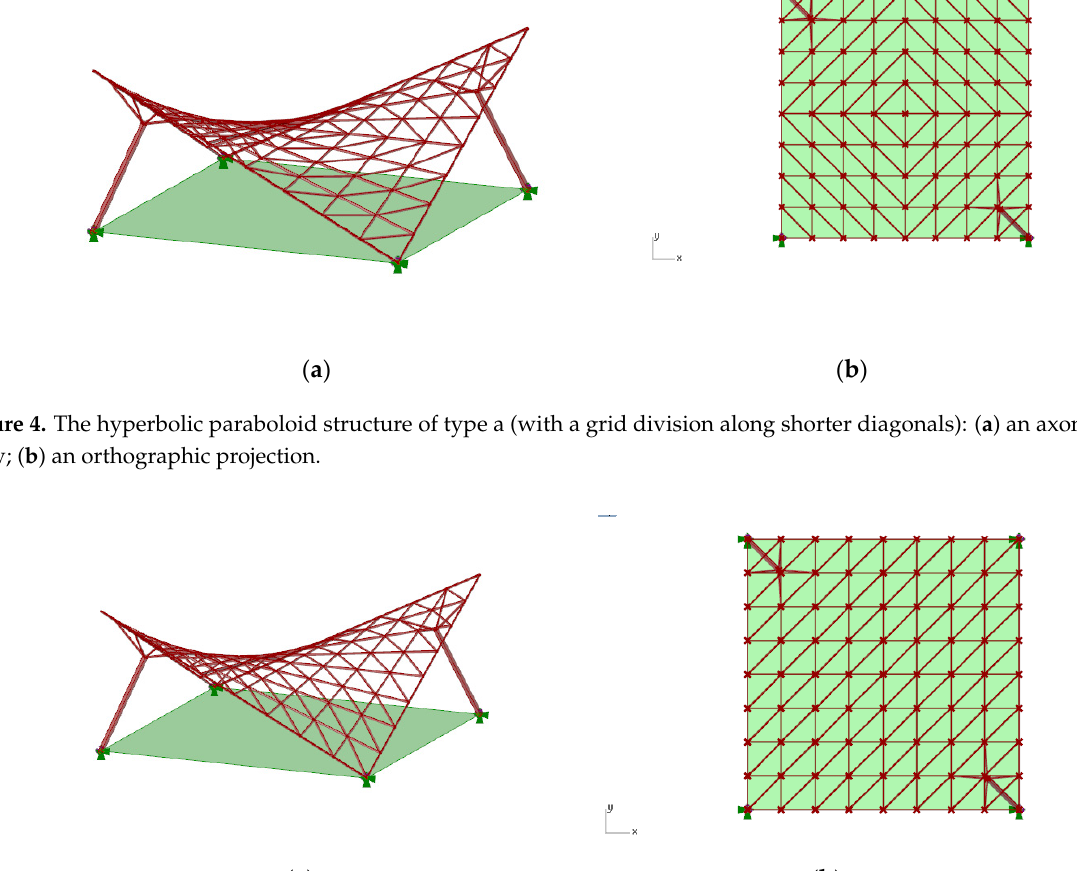
. Figure 6. The fragment of the Karamba 3D script for structural analysis.